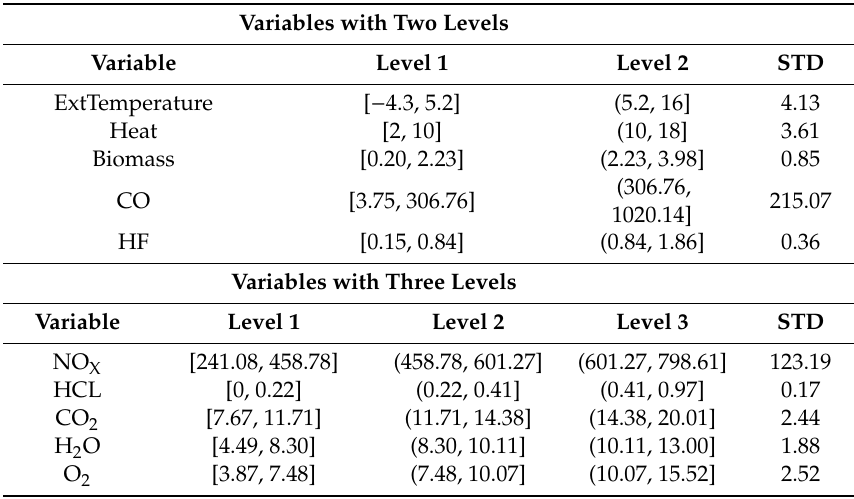
Table 2. Variable levels and standard deviation (STD).